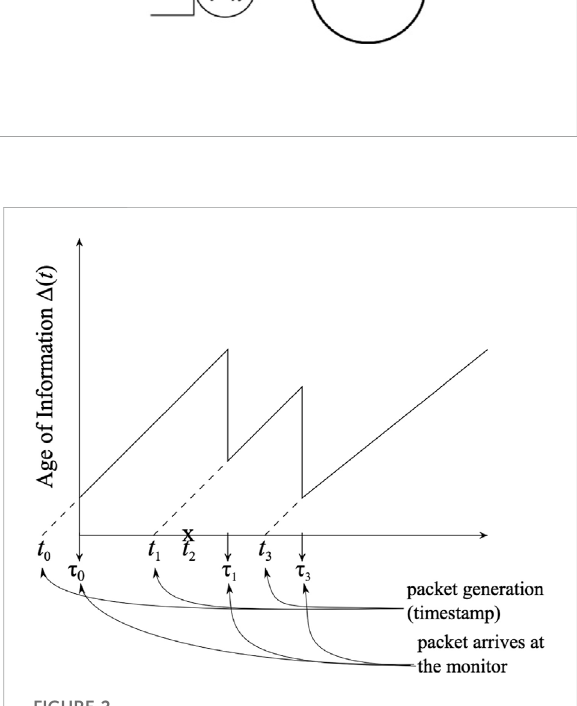
FIGURE 2 Age of information vs. time, single-capacity queue: t i and τ i are the time of generation and time of arrival at the monitor of the i th update,